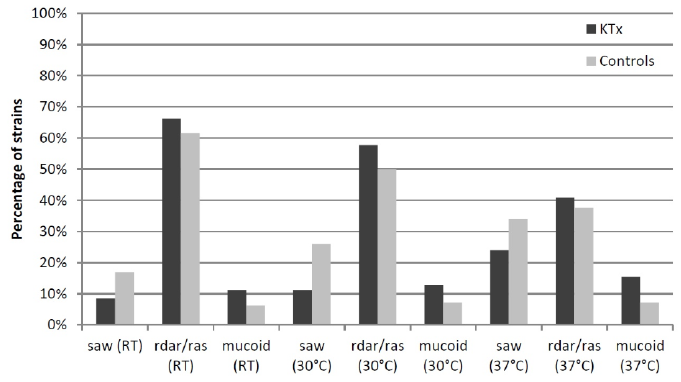
Figure 4. Expression of biofilm morphotypes in KTx and control UPEC isolates. The percentage of strains expressing different biofilm morphotypes at different growth temperatures is compared between the KTx and control groups.